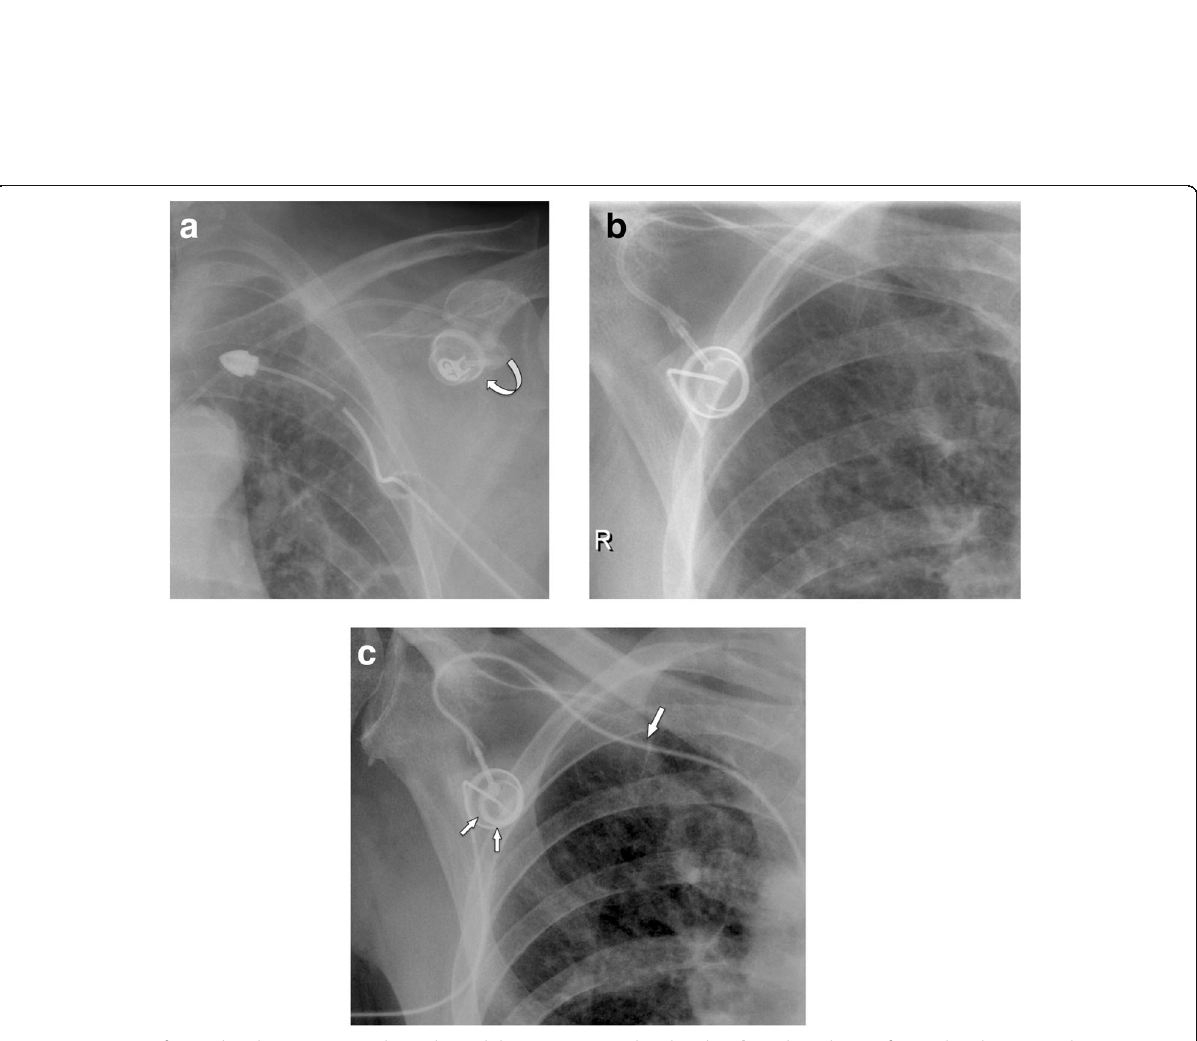
Fig. 9 a Twisting of port chamber (arrow) results in the inability to puncture the chamber. b , c Thrombosis of port chamber in another patient with increased flow resistance. Pre-contrast image shows the chamber, which only incompletely and marginally fills with contrast (small arrows). Note that the tube is completely opacified as proof of adequate injection (large